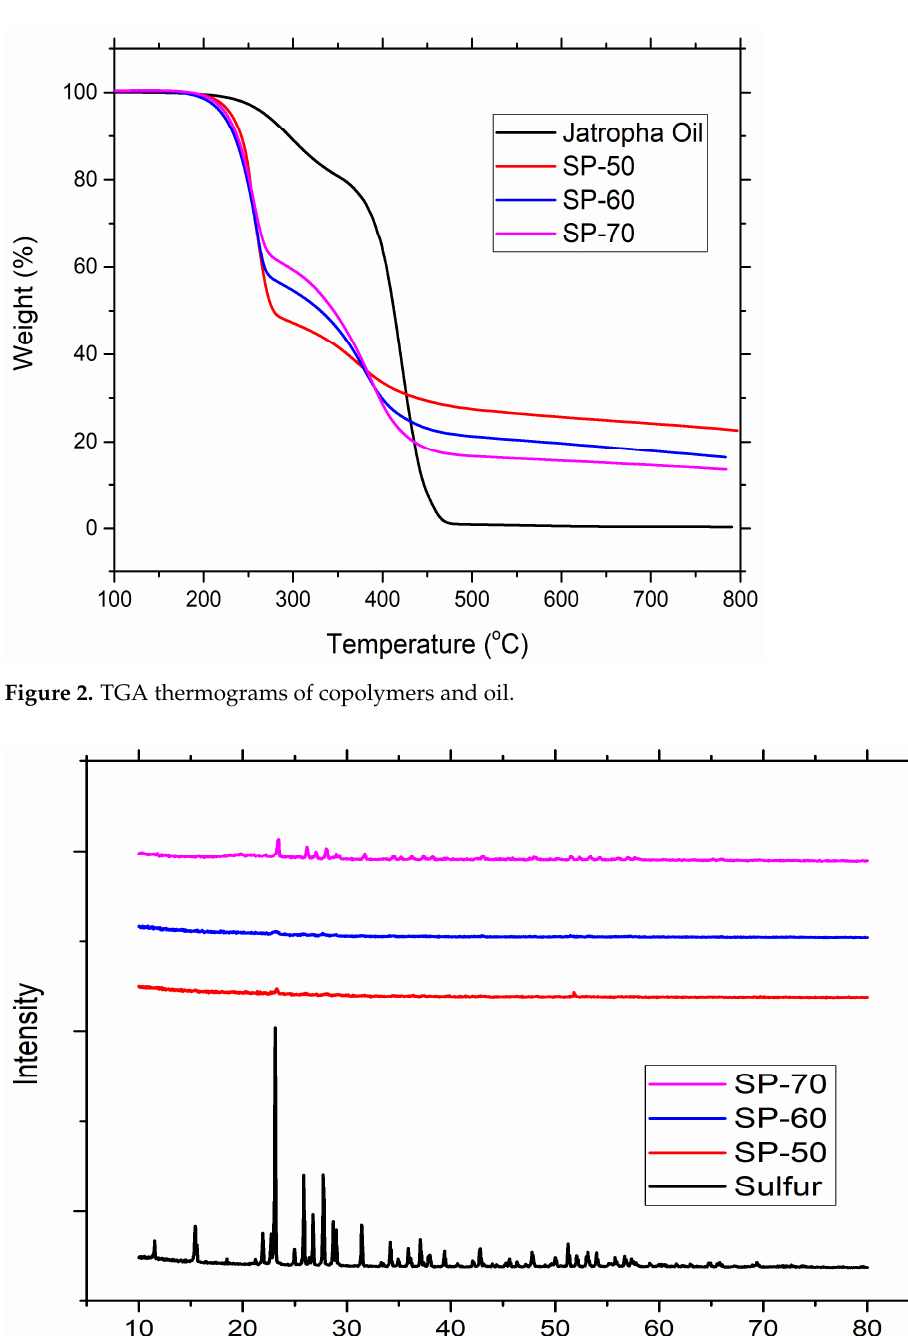
Figure 4. SEM images of copolymers with ( a ) 50, ( b ) 60, and ( c ) 70 wt% of S . FTIR spectra of all SUCFs are illustrated in Figure 5. By comparing the spectra of SUCFs with the copolymer, it was found that spectra of SUCFs possess peaks related to NH symmetrical stretching at 3430–3336 cm −1 , C=O stretching at 1675 cm −1 , stretching in NH or NH 2 at 1590 cm −1 , shortening of CN bond at 1460 and 1003 cm −1 , symmetrical stretching of NH at 1149 cm −1 , out-phase bending of OCNN at 787 cm −1 , and bending of NH at 714 cm −1 [47]. These peaks are considered characteristics of urea peaks. Appearance of these peaks in spectra of SUCFs and undisturbed peaks of the copolymer thus confirms the successful formation of fertilizer composite.